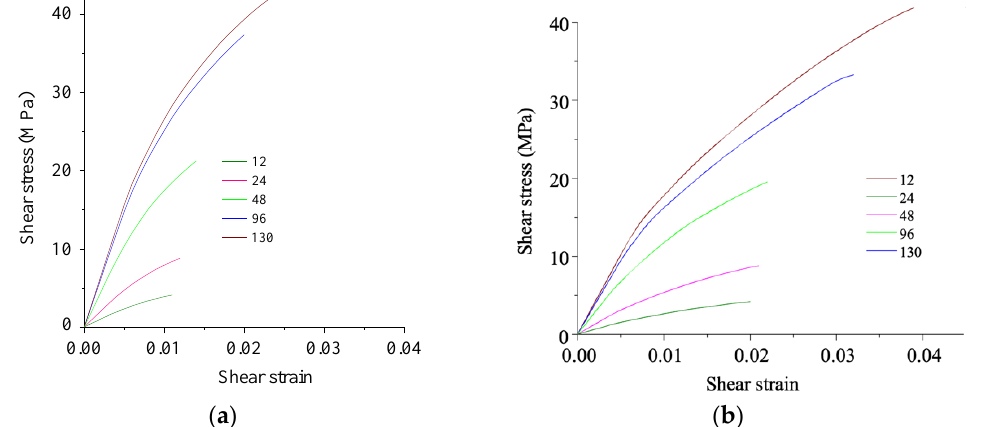
Figure 18. The shear stress–strain curves for the PEEK- ( a ) and PI-based ( b ) composites with changing contact points number.